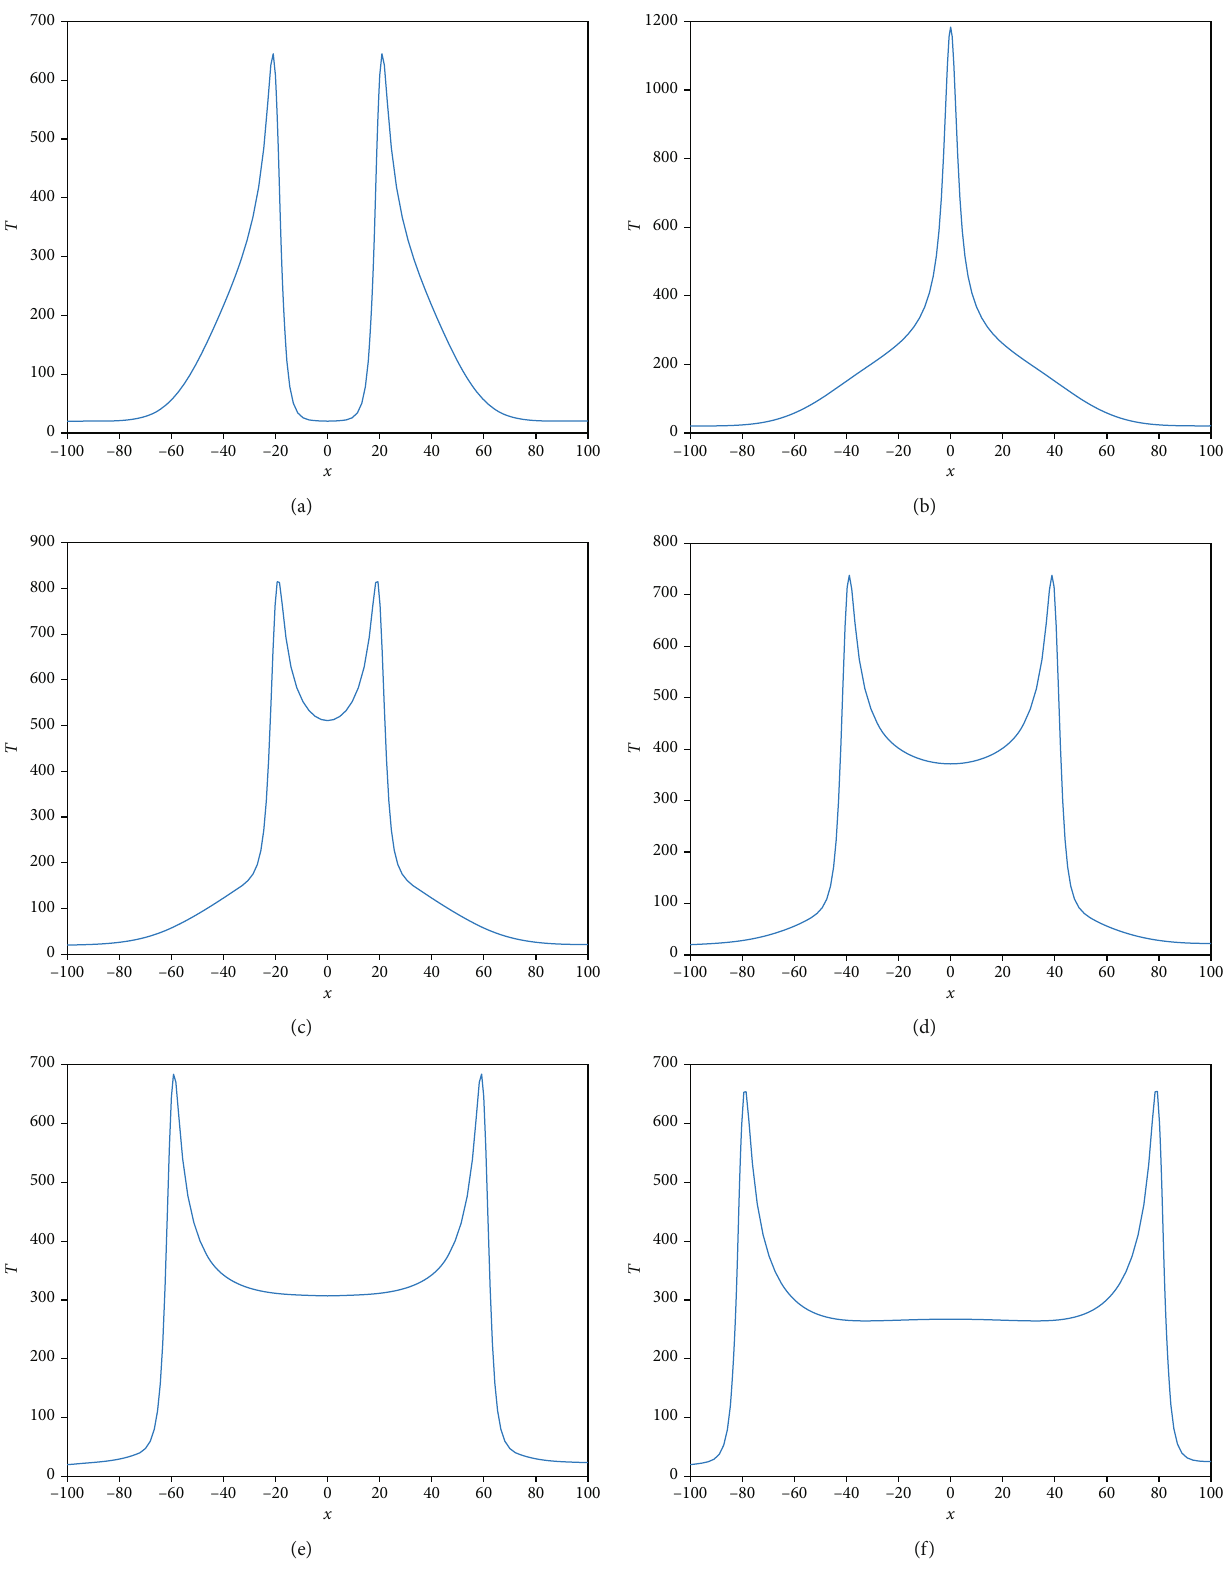
Figure 7: The transient temperature pro fi le along x -axis at t = 15 (a), 25 (b), 35 (c), 45 (d), 55 (e), and 65 (f), for two heat sources moving in opposite